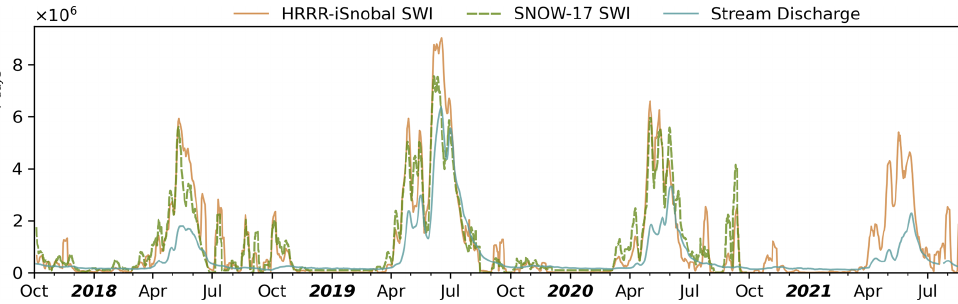
Figure 9. Time series comparison of simulated HRRR-iSnobal SWI and SNOW-17 SWI against the measured USGS stream gauge discharge across the 4 water years. Note: the data for SNOW-17 SWI were not available for